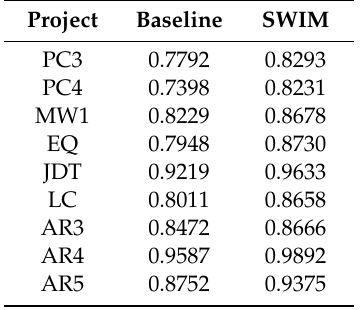
Table 1. AUC obtained by using SVM without sampling (Baseline), and with SWIM. Project Baseline